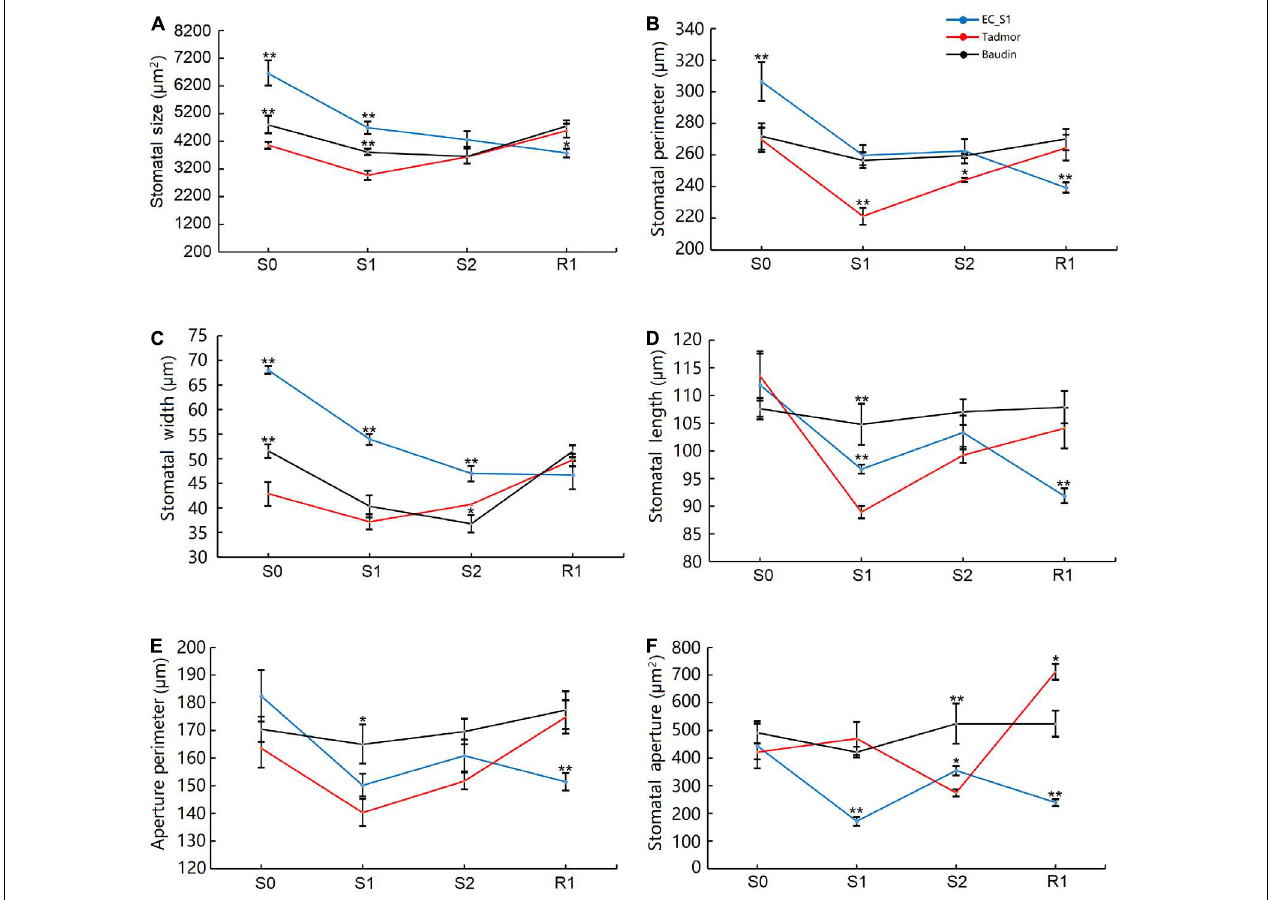
FIGURE 2 | Stomatal morphology of EC_S1, Tadmor and Baudin after drought treatment. (A) Stomatal size; (B) stomatal perimeter; (C) stomatal width; (D) stomatal length; (E) aperture perimeter; (F) stomatal aperture. * and ** indicate significance levels at P ≤ 0.05 and 0.01, respectively ( n = 3 independent